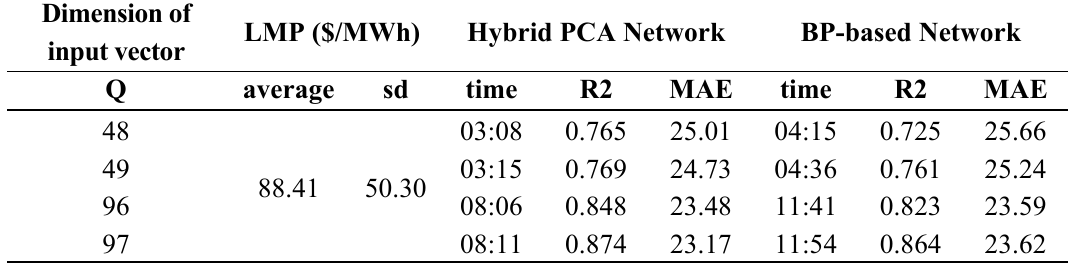
Table 7. Performance comparison between the proposed hybrid PCA and BP-based neural network (Byberry, fall).